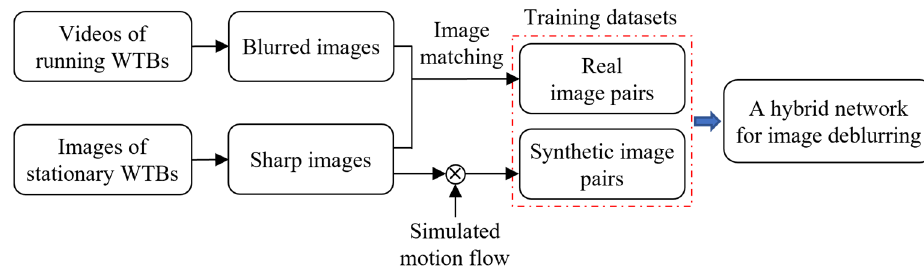
Figure 1. Flowchart of the dataset synthesis process.